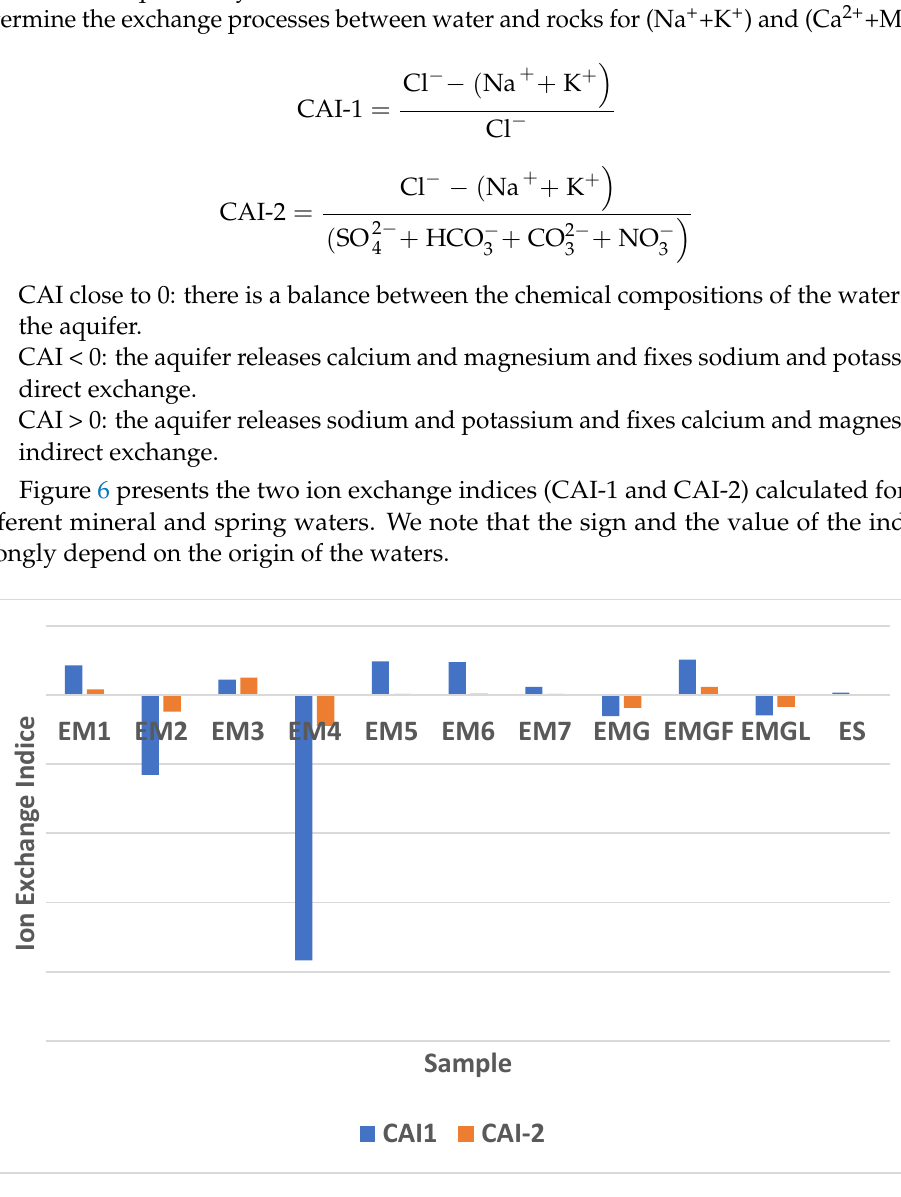
Figure 6. Ion exchange indices.